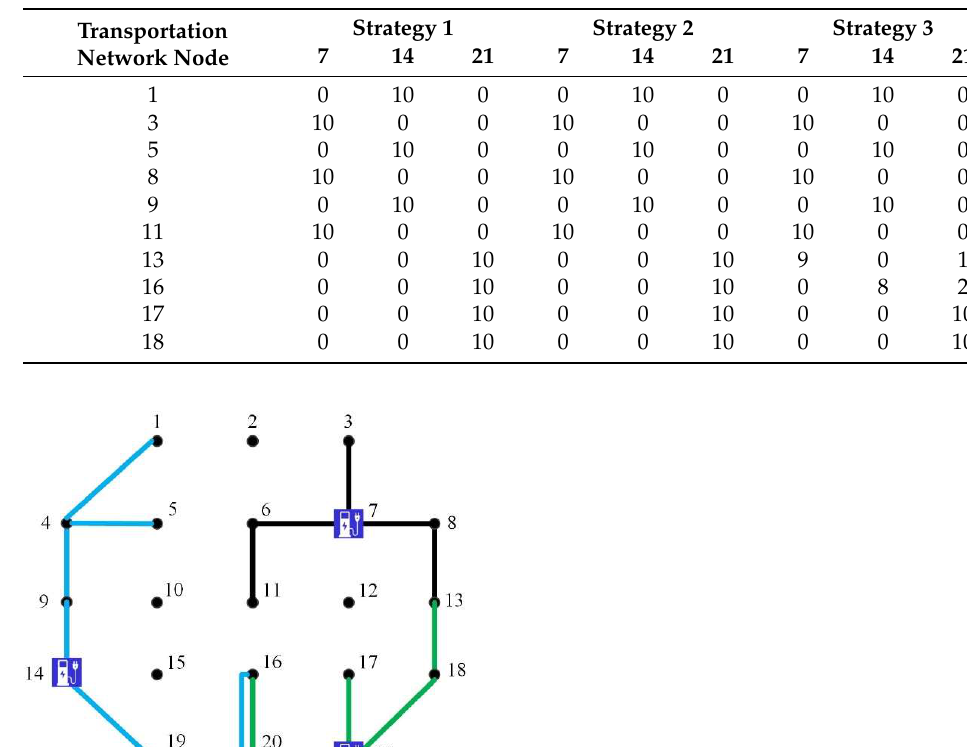
Table 6. Assignment results of charging stations for all EVs in the three strategies.